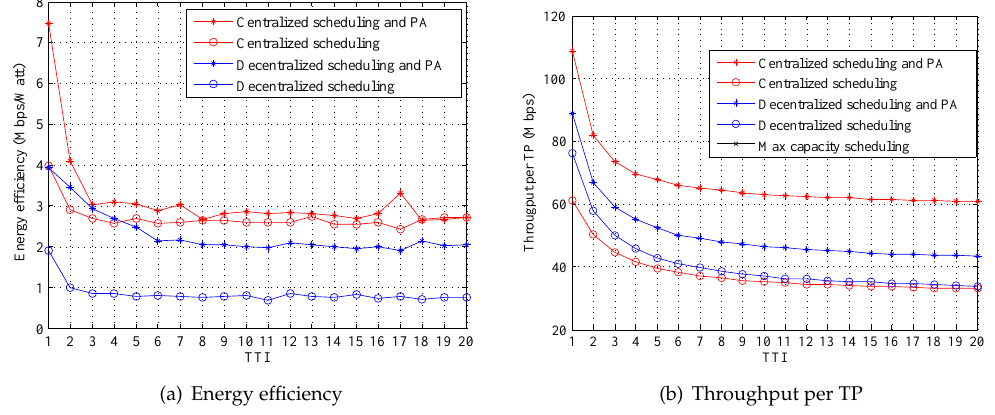
Figure 6. System performance under different strategies (40 Watts, infinite C m , R thres = 180 kbps).